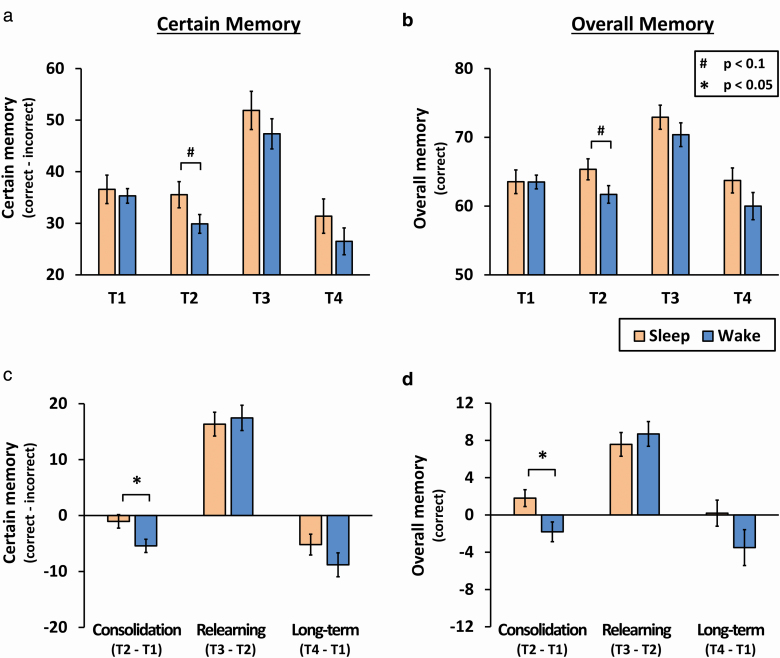
Results for certain and overall memory. (A) Performance at each test for memories rated as certain and (B) memory scores overall. (C) For certain memories, the sleep group remembered significantly more than the wake group after the retention interval (consolidation), indicating sleep-dependent consolidation of factual knowledge. However there was no significant difference between the two groups after relearning or after 1 week. (D) Overall memory scores showed the same pattern. Mean ± SEM.